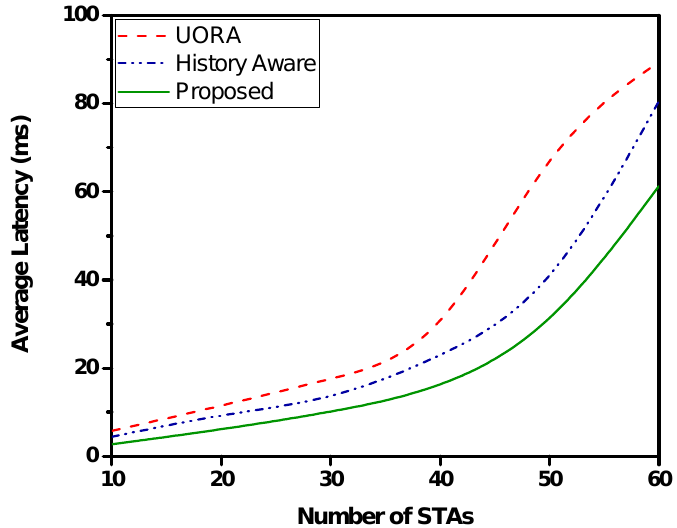
Figure 5. Average UL latency. As the number of STAs increases, the average latency